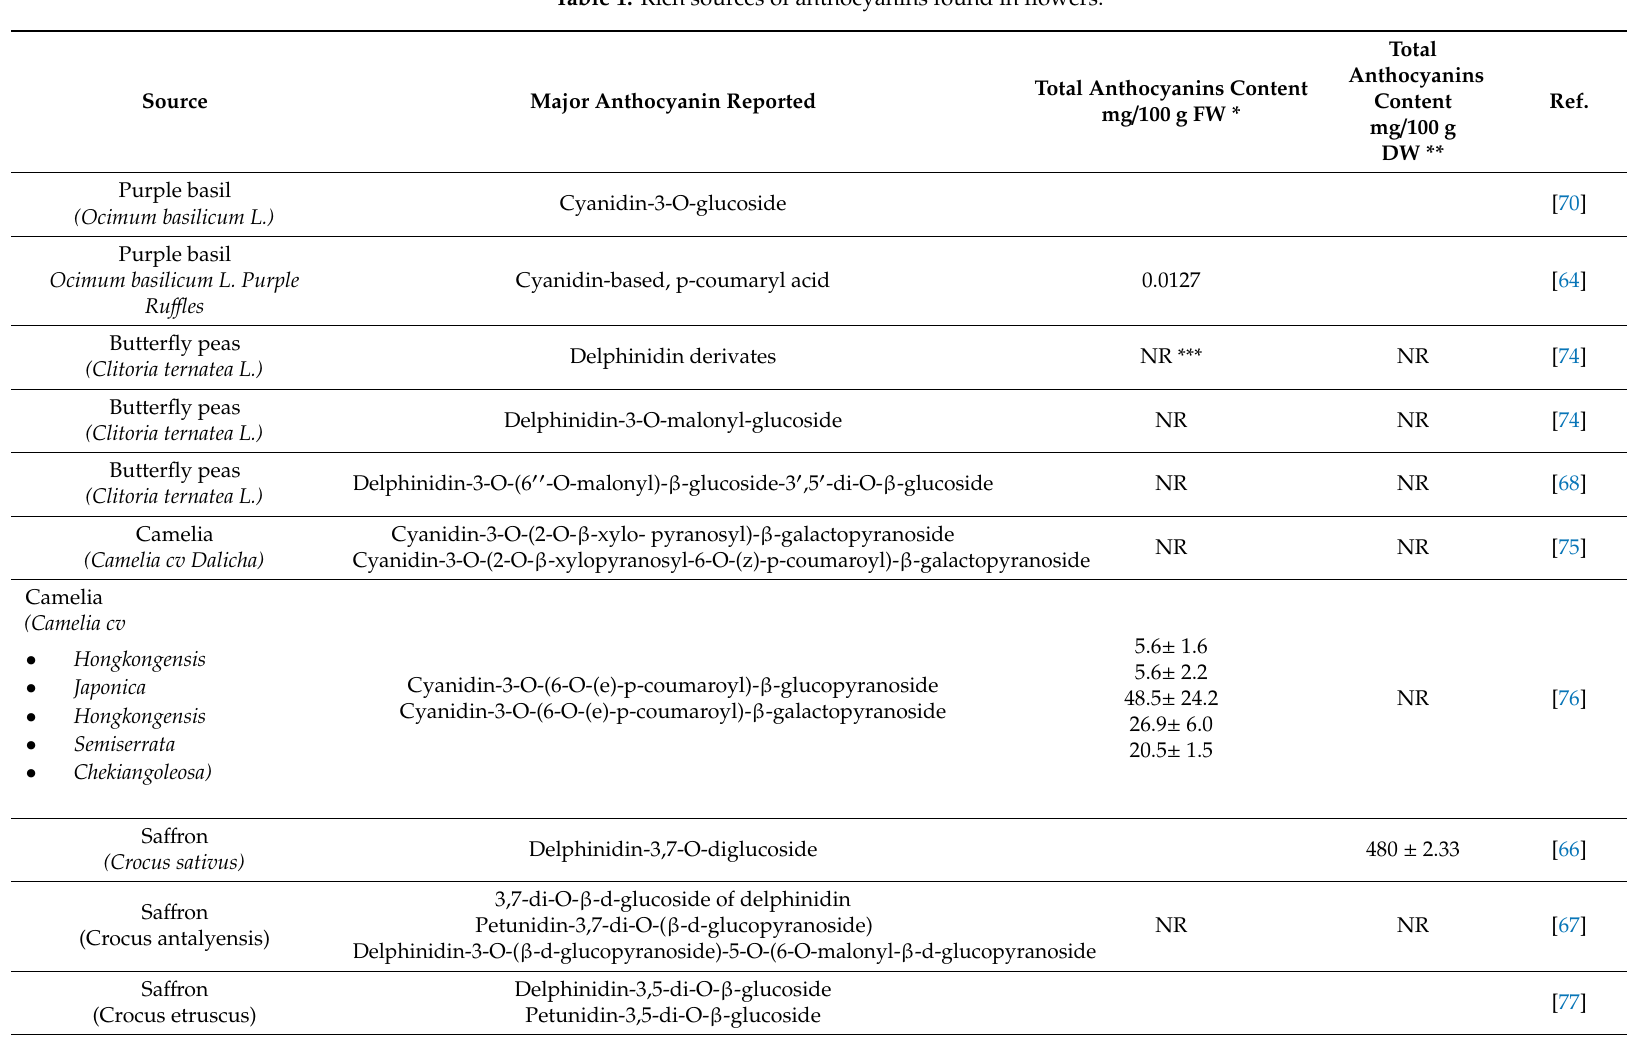
Table 1. Rich sources of anthocyanins found in